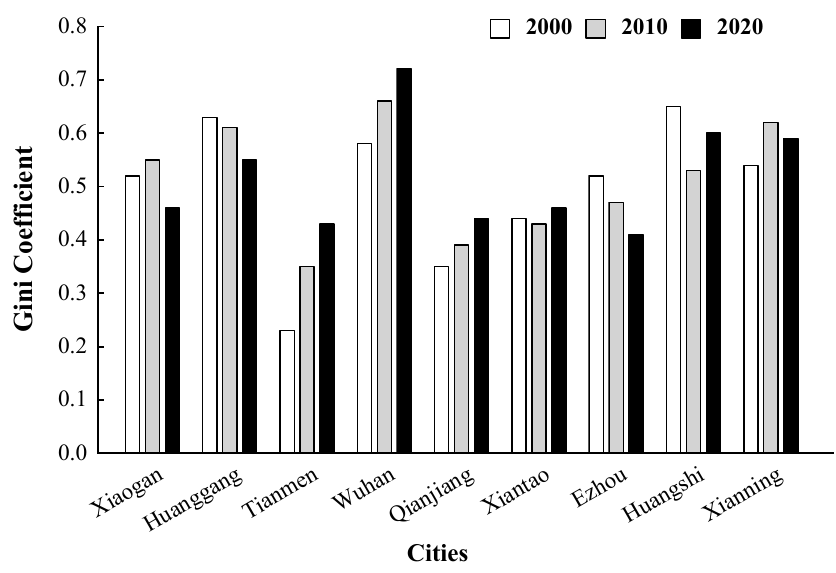
Figure 8. Histogram of the Gini coefficient on city level.